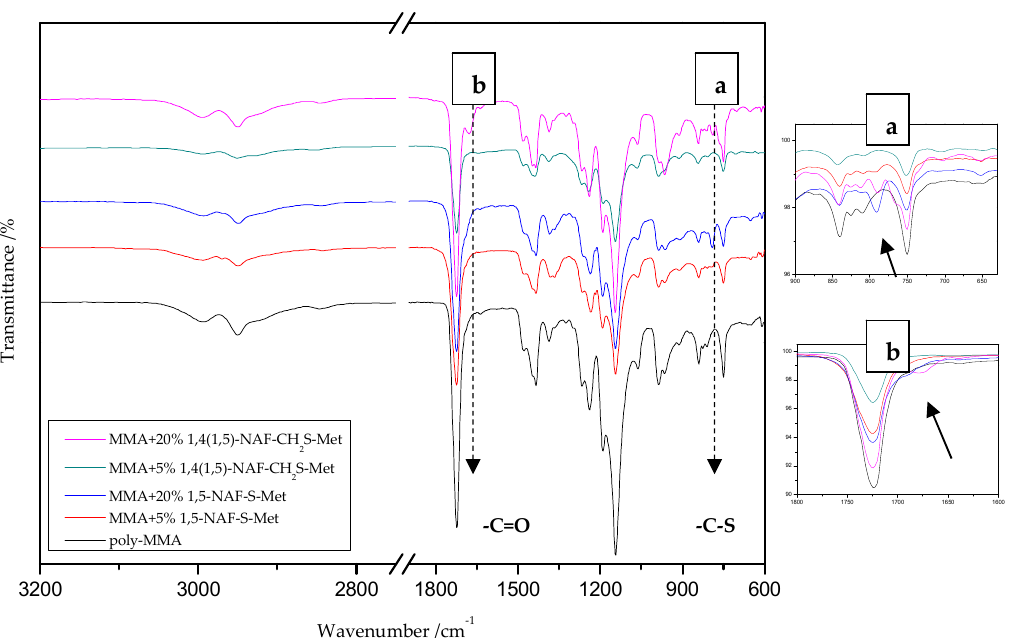
Figure 3. The attenuated total reflectance (ATR)/FTIR spectra of poly-methyl methacrylate (MMA) and its copolymers with 5% and 20% addition of 1,5-NAF-S-Met and 1,4(1,5)-NAF-CH 2 S-Met.